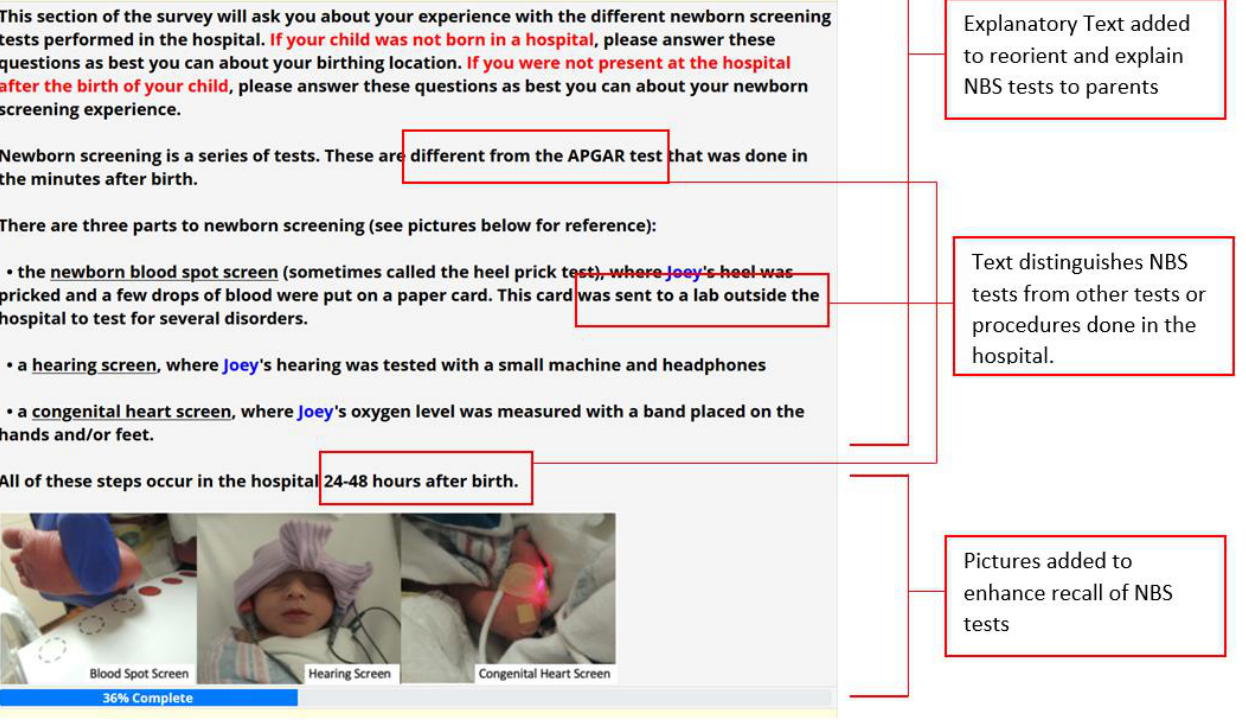
Figure 1. Newborn Screening Introduction Text Revisions based on Pretest Feedback.